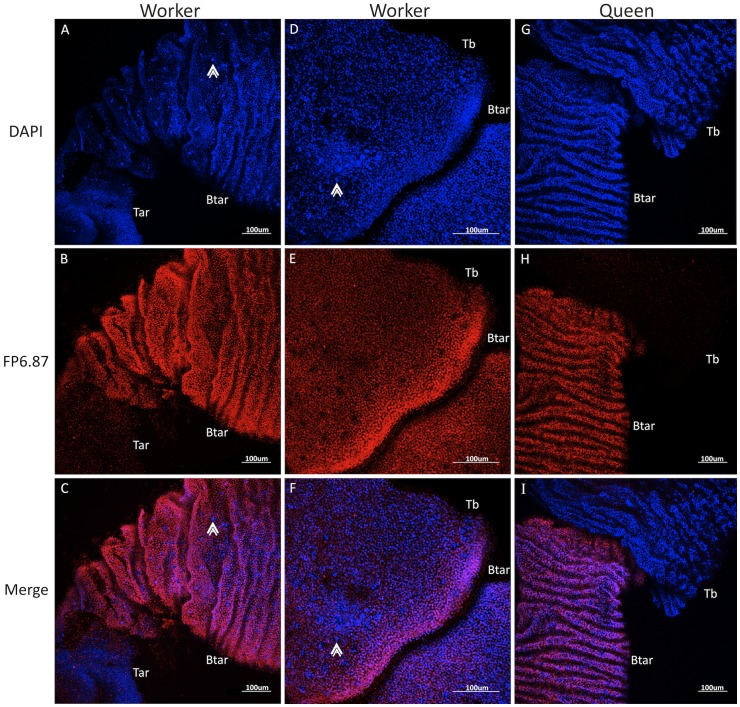
Immunolocalization of Ubx (FP6.87 antibody) in honeybee prepupal hind legs.
A-F: Ubx is expressed in the tibia and basitarsi of worker pre-pupae. Note that nuclei that do not express Ubx are arranged in a similar pattern to that of bristles in the adult hind leg (arrowhead) (see Figure 1D). G-I: Ubx is expressed only in the basitarsi of queen pre-pupae hind legs. In blue: DAPI; in red: Ubx; Tar: tarsi; Btar: basitarsi; Tb: tibia. Original scale bars of confocal system.